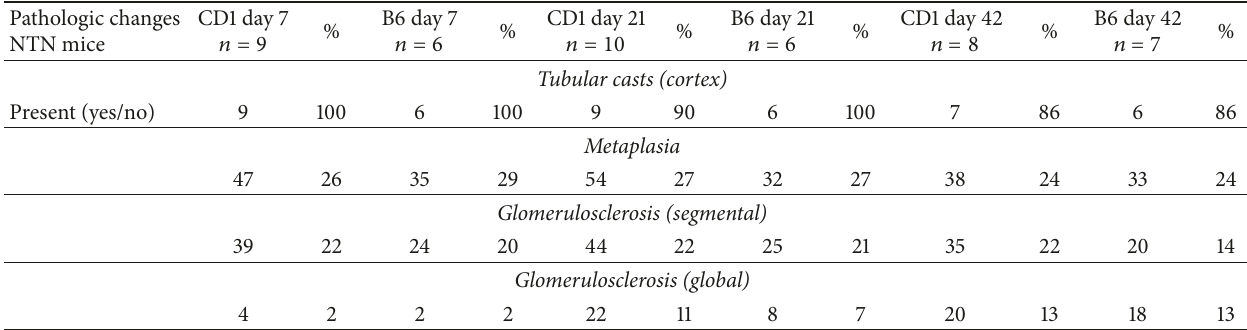
Table 1: Histopathological lesions by mouse strains . The tubular casts were visualised as solidification of protein in the lumen of the kidney tubules. The metaplasia was visualised as a change from flattened parietal epithelium to cuboidal epithelium lining the glomerulus. The segmental glomerulosclerosis was visualised as glomeruli that showed scarring of small sections of the glomeruli, while global glomerulosclerosis was visualised as totally scarred